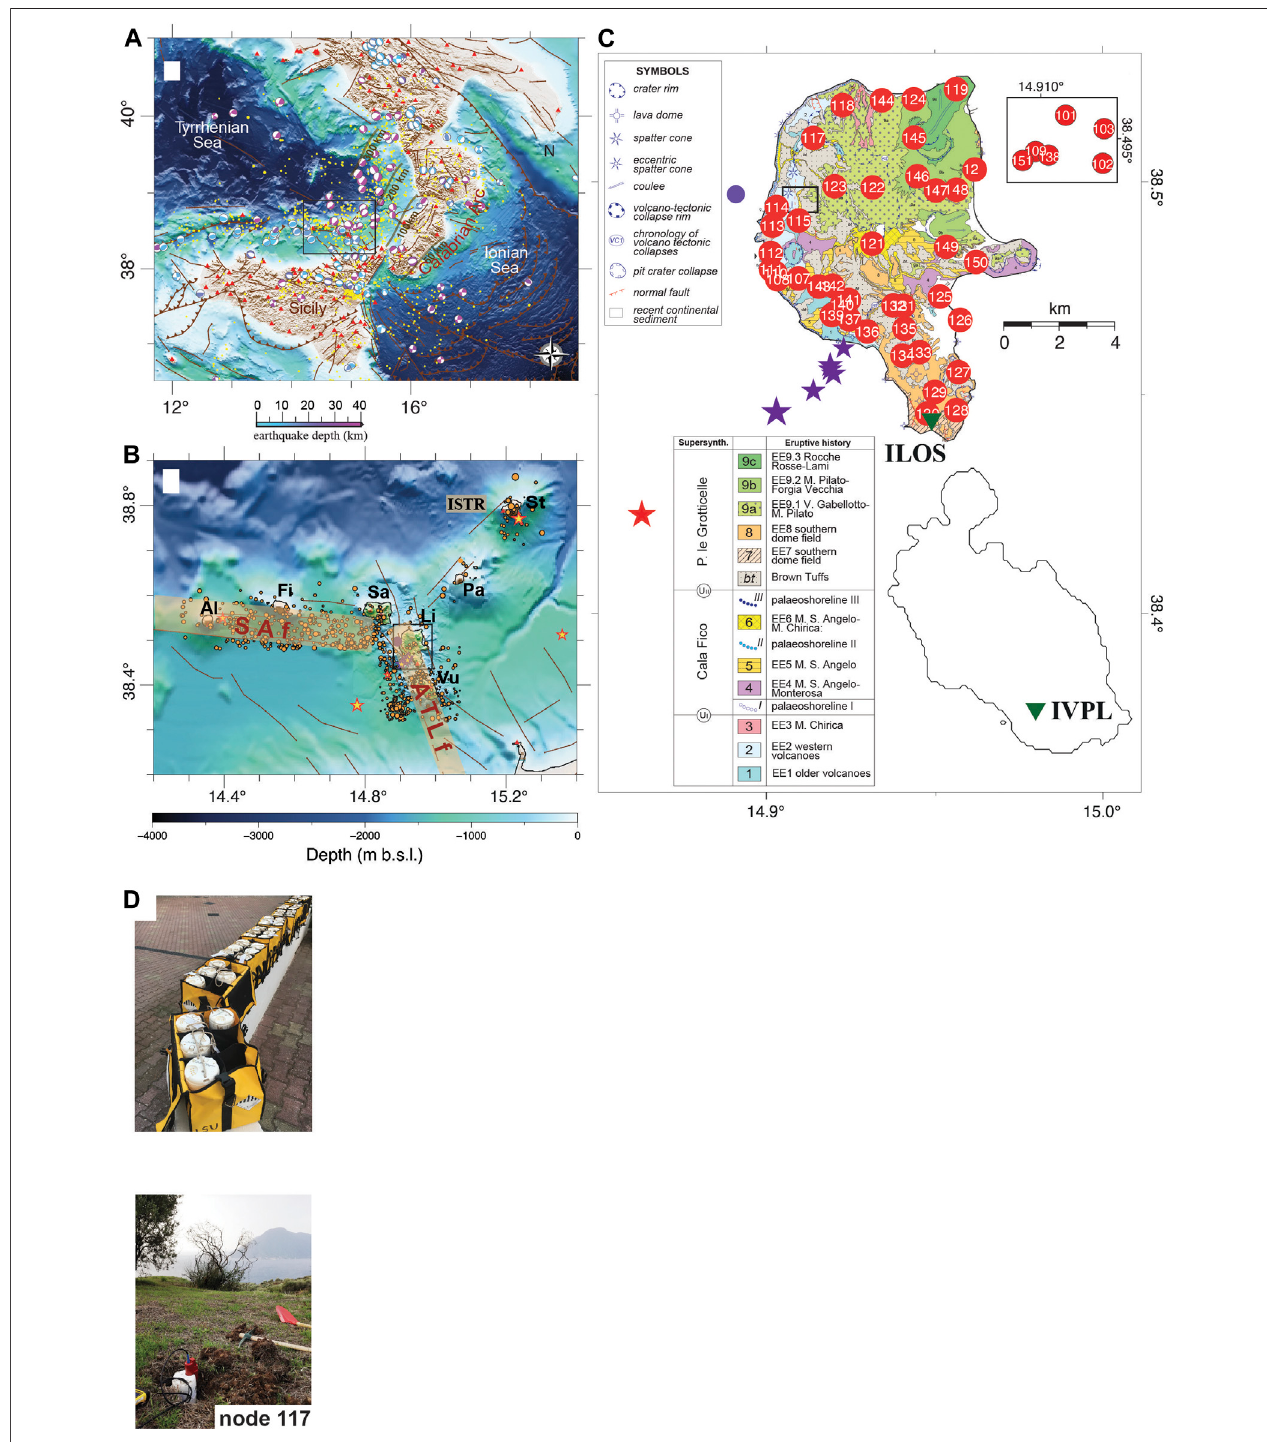
FIGURE1|(A) MapofSouthernItaly.Themainfaultsandthrusts(brownlines)arefromPalanoetal.(2015).Slabisodepthsat50,100,200and300 kmareshown with gray lines. Red triangles are the broadband seismic stations of the INGV permanent network (http://cnt.rm.ingv.it/instruments/network/IV). The 2000 – 2019 seismicityfromtheINGVseismiccatalog(http://iside.rm.ingv.it/)isshownasyellowdots.RegionalCentroidMomentTensorsolutions(http://rcmt2.bo.ingv.it/)forevents largerthan4.5arecolor-codedbydepth.Theblackrectangleoutlinestheareashownin (B) ,wherethemaintectonicstructuresareshown:SAf (cid:1) theSisifo-Alicudi faultsystem;ATLf (cid:1) theAeolian-Tindari-Letojannifaultsystem.Fromwesttoeast,theAeolianislandsarealsolabeled:Al (cid:1) Alicudi;Fi (cid:1) Filicudi;Sa (cid:1) Salina;Li (cid:1) Lipari;Vu (cid:1) Vulcano; Pa (cid:1) Panarea; St (cid:1) Stromboli. ISTR is the tyde station at Stromboli island. The Aeolian seismicity (orange circles) is from Gruppo Analisi Dati Sismici (2021)